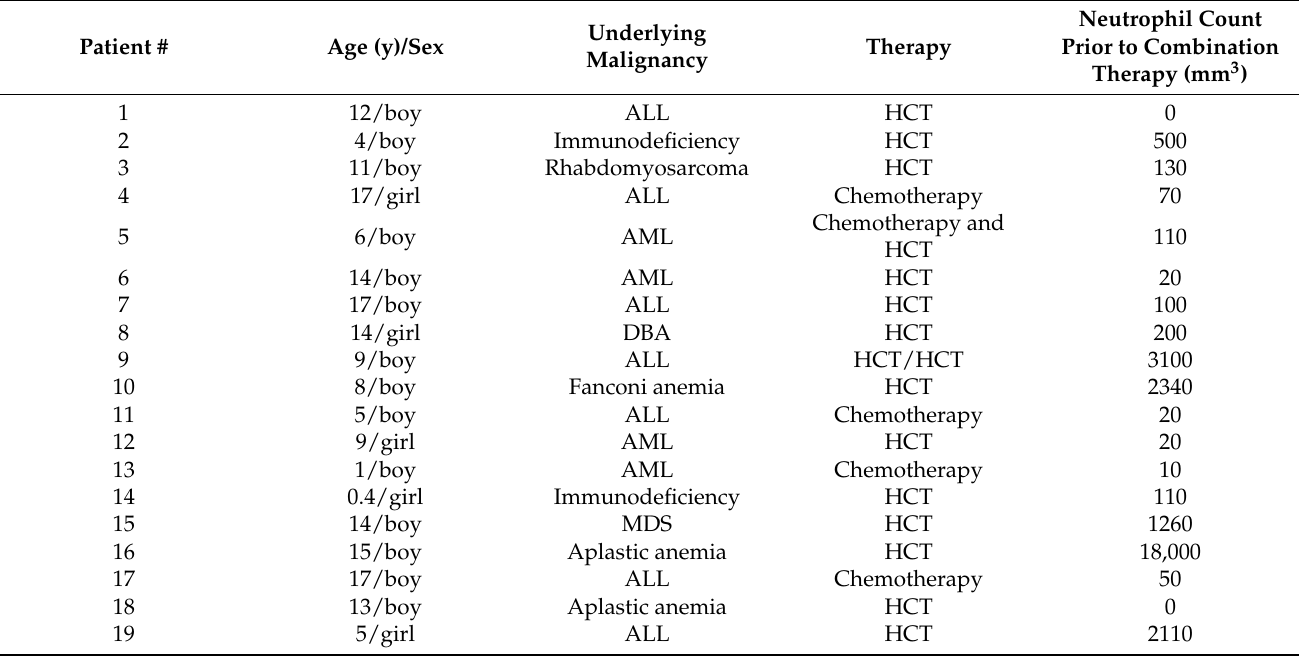
Table 1. Demographics of 19 pediatric patients receiving antifungal combination